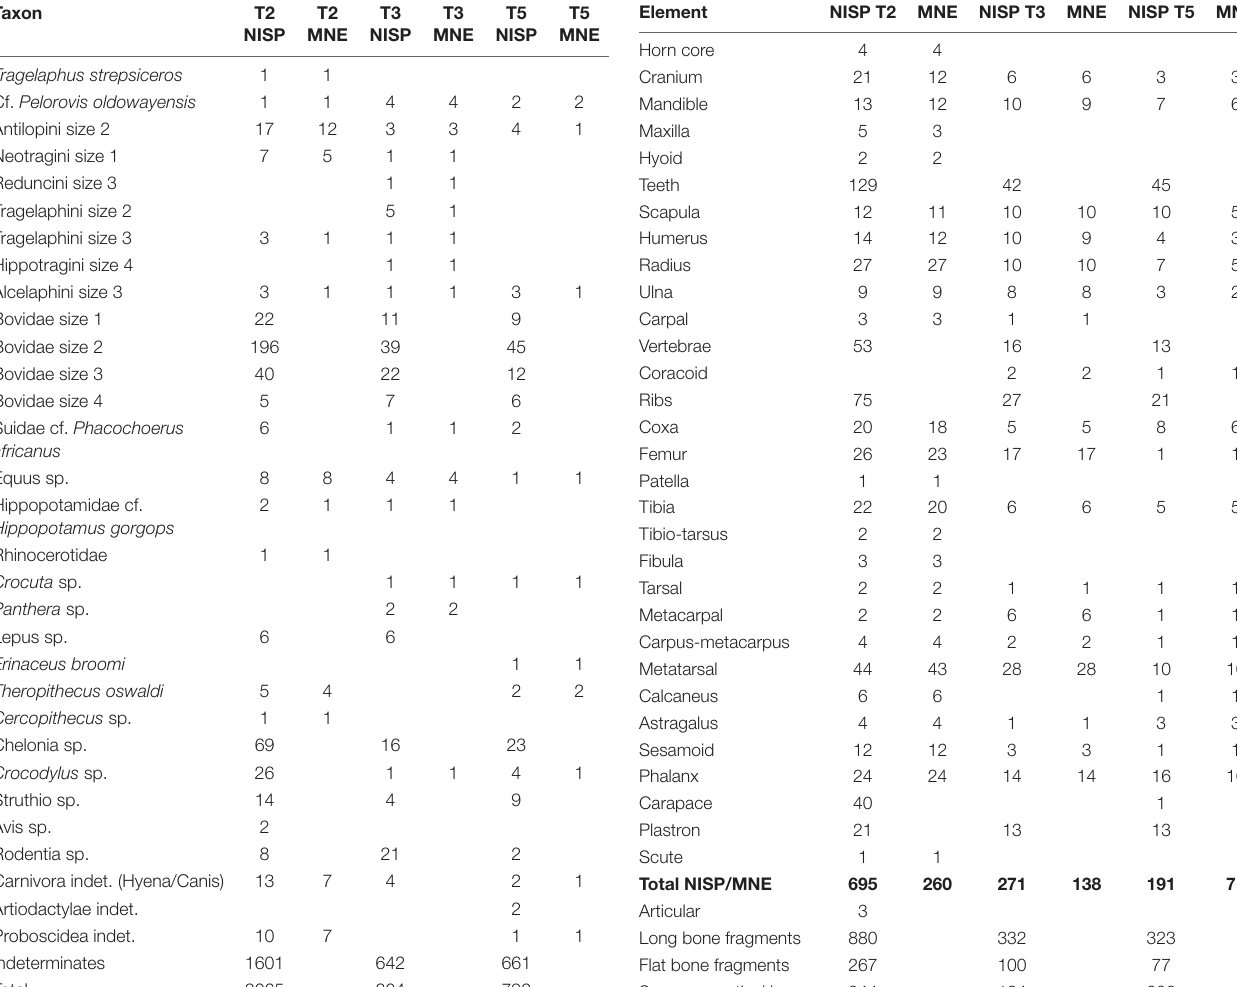
TABLE 1 | Represented taxa in the trenches 2, 3, and 5 at Ewass Oldupa. TABLE 2 | Representation of elements and quantification through NISP and MNE.